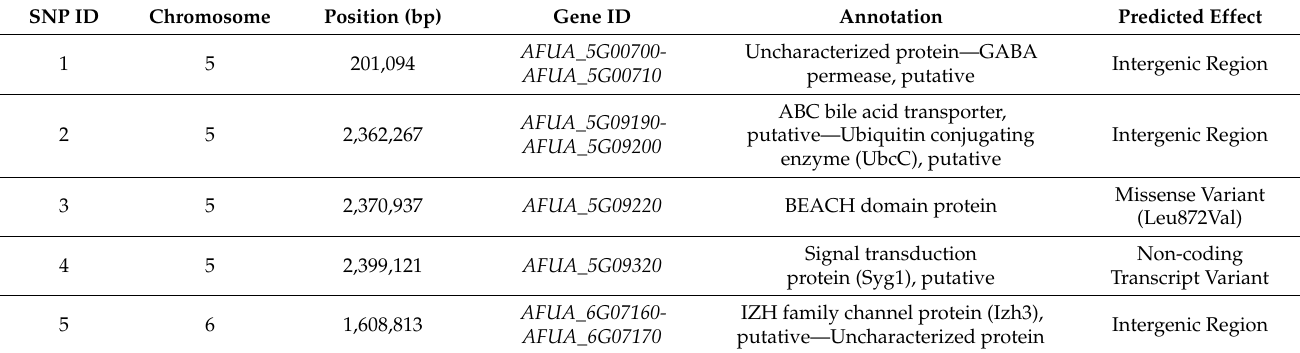
Table 5. Information about the five SNP sites that were genotyped in the progeny strains using